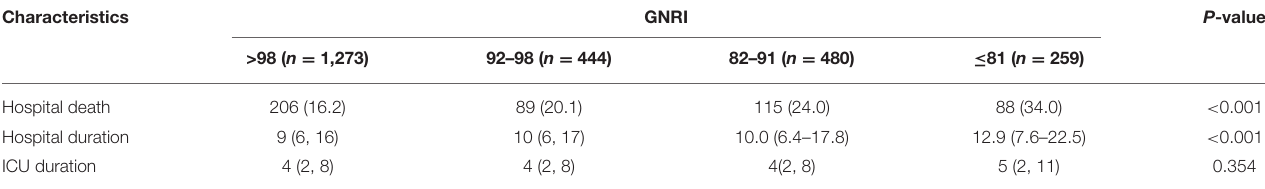
TABLE 6 | Comparison of hospitalization outcomes and prognosis of patients with different nutritional status.